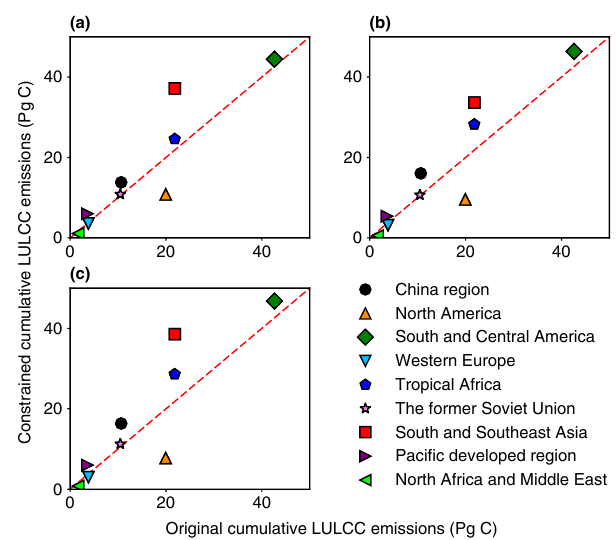
Figure 5. Comparisons between the original TRENDY land-use and land-cover change (LULCC) emissions and the cumulative LULCC emissions constrained by the biomass dataset from Carvalhais et al. (2014). Panels (a) , (b) and (c) are the results from Method A, Method B and Method C, respectively. The original TRENDY emis- sions are shown as the median value of all models. Dashed line is the 1 : 1 line.